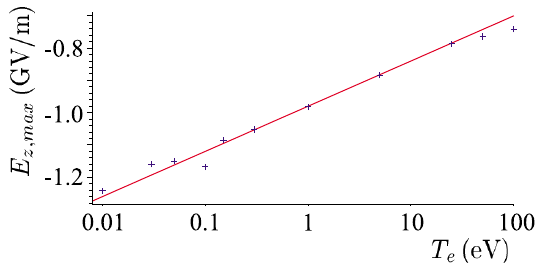
FIG. 6. (Color) The temperature dependence of the spike am- plitude: simulation (crosses) and approximation